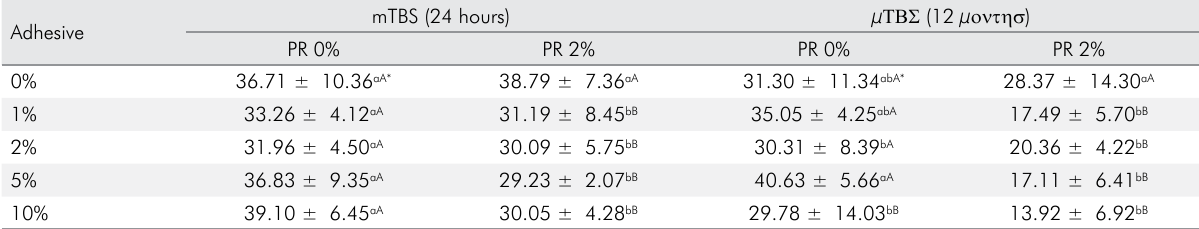
Table 2. Immediate (24 hours) and longitudinal (12 months) microtensile bond strength ( μ TBS, in MPa).